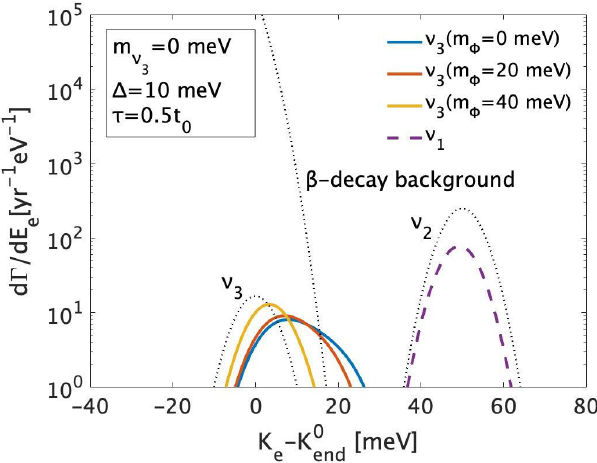
= 0 meV from the 2-body decays , ν , in the Figure 4 . The expected spectra with m ν 1 → ν 3 φ 3 neutrino capture on 100 g of tritium for the IO case. We set τ = 0 . 5 t with ∆ = 10 meV and ν 1 0 several values of m . Blue, red and yellow lines denote the spectra for ν produced by the decays φ 3 of ν for m = 0 , 20 , 40 meV , respectively. A purple dashed line denotes the spectrum for ν 1 φ 1 produced in the early universe but suppressed by the decays of ν . Black dotted lines denote the 1 contributions of the spectra of ν and ν produced in the early universe and β -decay background. 2 3 Note that the actual spectrum is a superposition of these